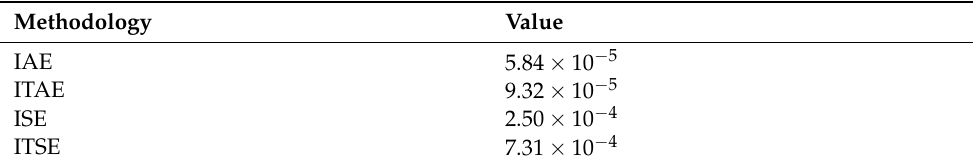
Table 5. Minimization results for the voltage loop.